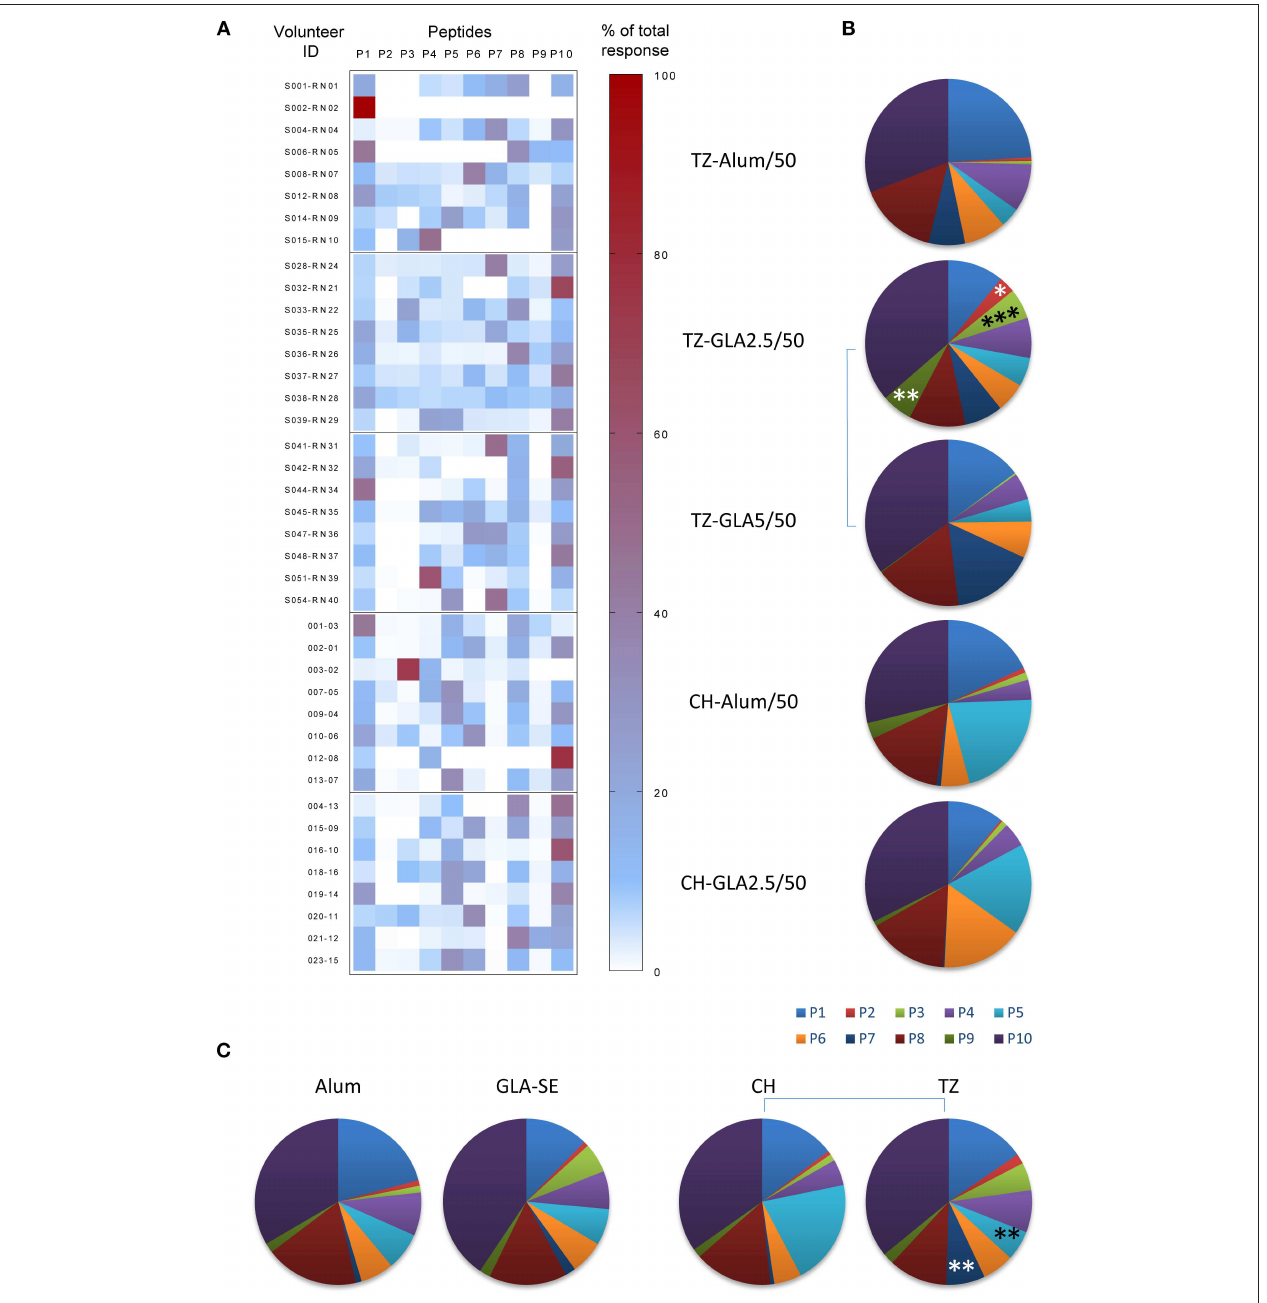
FIGURE 3 | Repartition of the fine specificity of the humoral response along the sequence of P27A at D84 in Phase 1a and 1b. The fine specificity of the humoral response was determined by ELISA using sera from unexposed volunteers (CH-Alum/50 and CH-GLA2.5/50) and exposed volunteers (TZ-Alum/50, TZ-GLA2.5/50, and TZ-GLA5/50) against individual 20-mer peptides. (A) Heat map indicates the individual repartition of antibody responses to each 20-mer peptide, P1 to P10, over the sum of the responses, for each vaccination group. Right Y-axis represents the volunteer ID and the left Y-axis denotes the percentage value. (B) Pie graphs show the median proportion of humoral response to each 20-mer peptide for each vaccination group. (C) Pie graphs represent the median repartition of humoral responses of all volunteers grouped either by adjuvant type (Alum or GLA-SE) or by site (CH or TZ). Comparisons per peptide were done using Mann-Whitney test; * p < 0.05; ** p < 0.01; *** p <